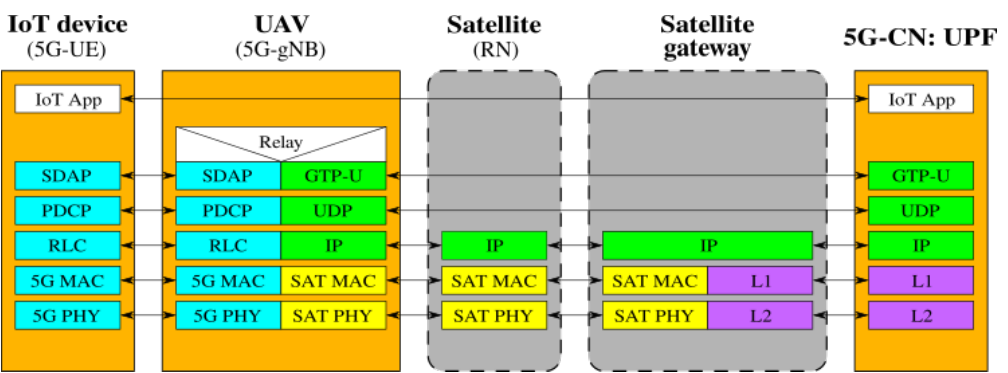
Figure 6. 5G-UE in the IoT device and 5G-gNB on the satellite.